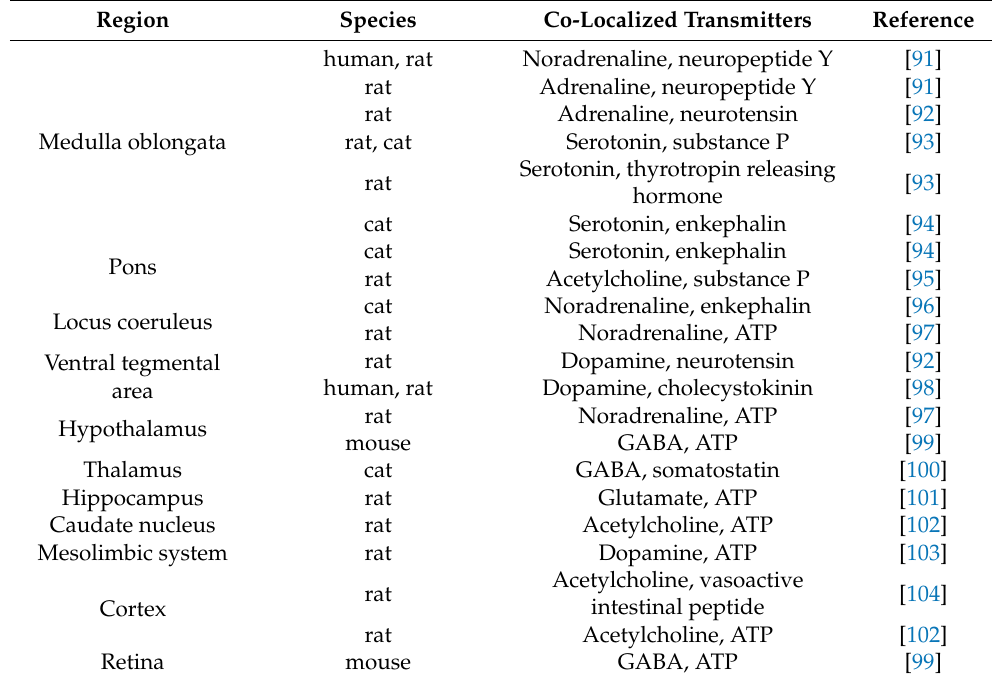
Table 1, neuropeptides represent the largest class of neurotransmitters commonly present as cotransmitters [90]. Table 1. Co-localized transmitters in CNS